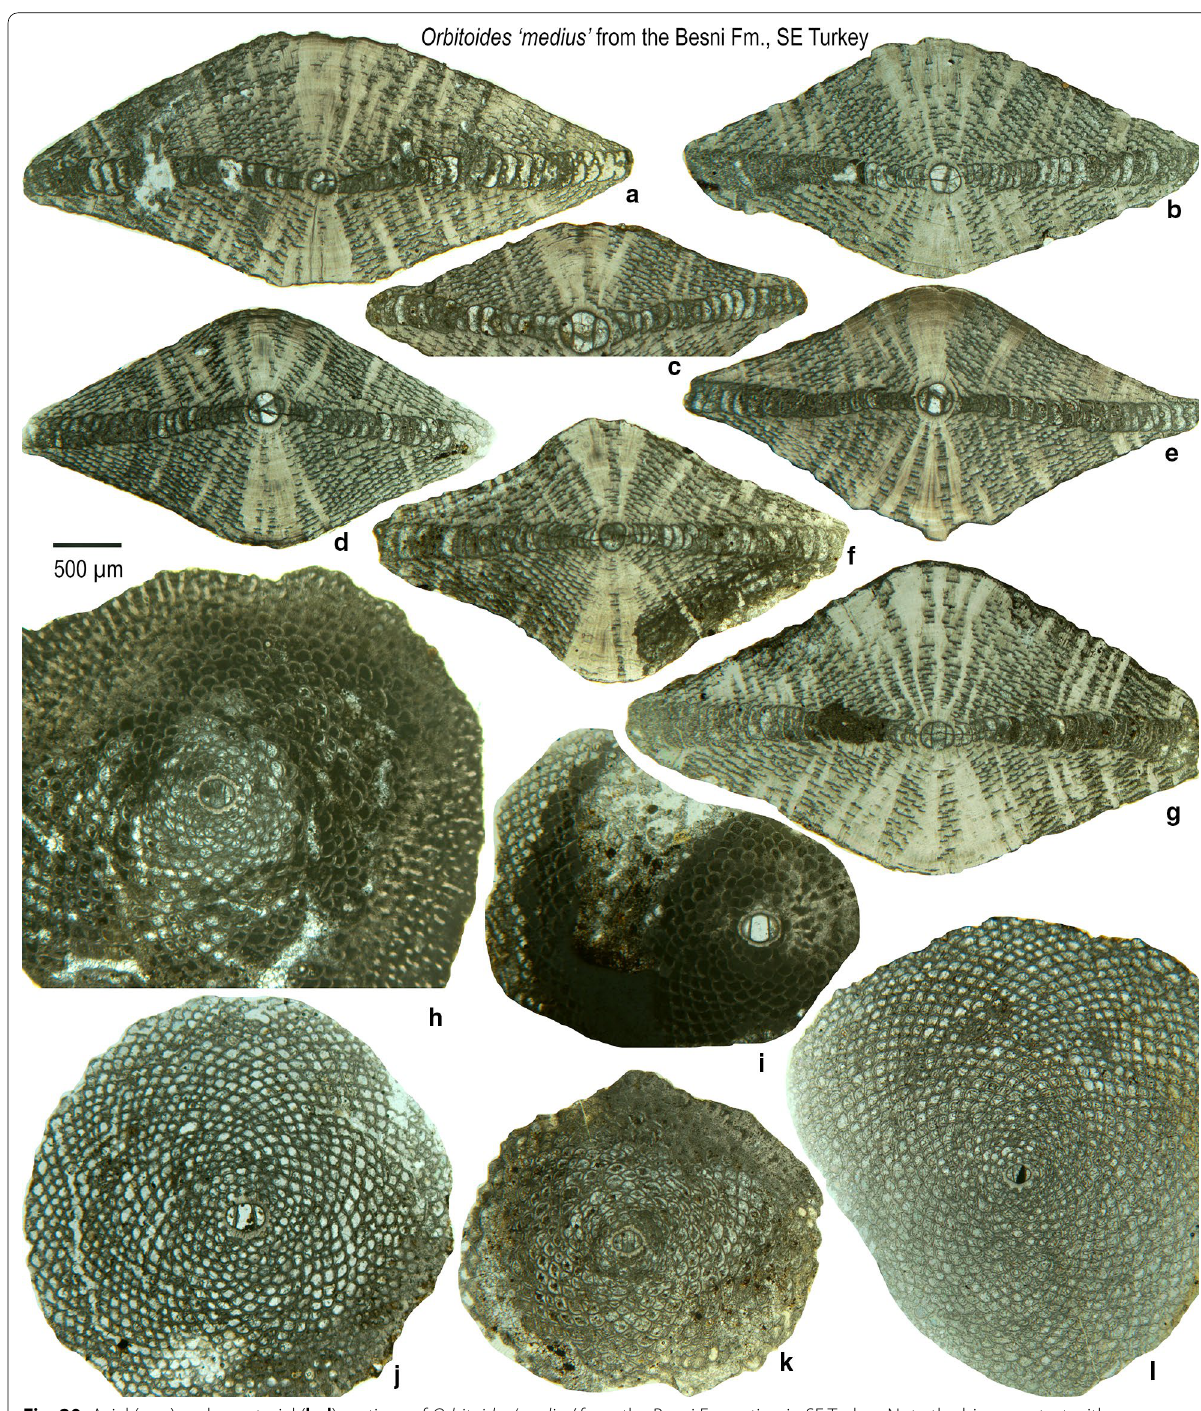
Fig. 20 Axial ( a – g ) and equatorial ( h – l ) sections of Orbitoides ‘medius’ from the Besni Formation in SE Turkey. Note the biconvex test with numerous cycles of lateral chamberlets and thick polar piles, and a thick equatorial layer. a TC7-47. b TC7-48. c TC7-43. d TC7-50. e TC7-44. f TC13-48. g TC13-47. h TC13-40. i TC8-78, j TC8-79. k TC13-43. l